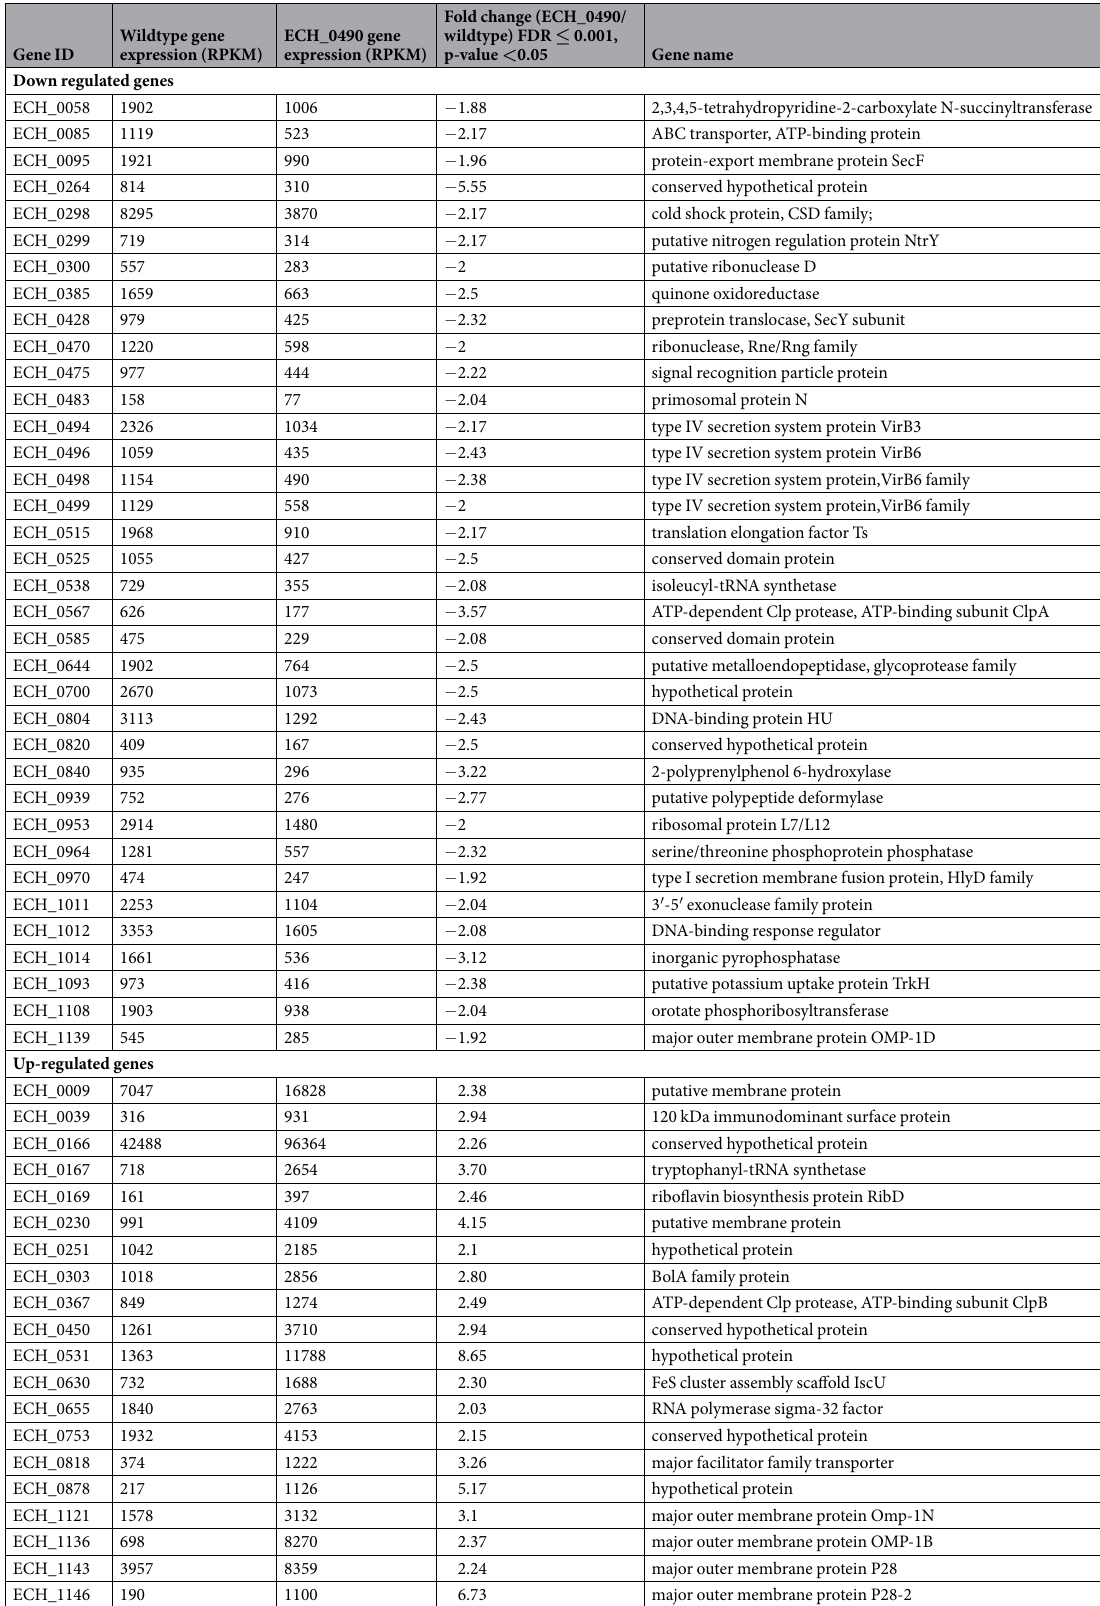
Table 3. E . chaffeensis genes differentially transcribed in ECH_0490 compared to